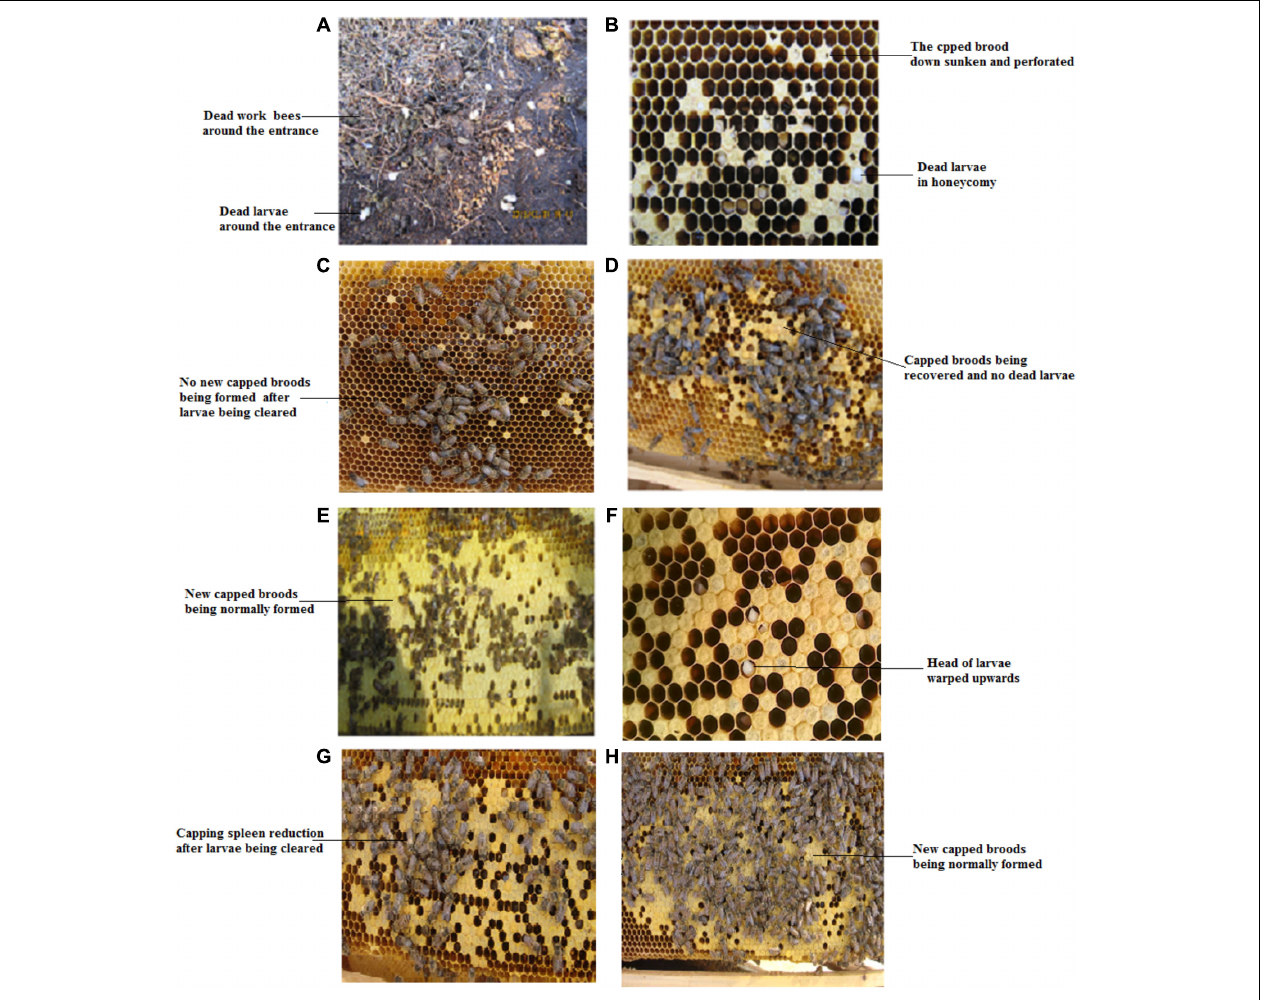
FIGURE 4 | Clinical symptoms of Apis cerana larvae infected with CSBV, and effect of treatment with anti-CSBV IgY. (A) Numerous larvae were dragged out of the colony, and dead worker bees were observed in the serious infection group. (B) Capped broods not being normally sealed, down sunken and perforated, were observed in the serious infection group. (C) No new capped broods being formed after larvae infected with CSBV being cleared in the serious infection group. (D) New capped broods begin to be formed, and no larvae were dragged out of the colony from 7 to 13 days after IgY treatment in the serious infection group. (E) The heads of larvae infected with CSBV were warped upward. (F) The capped brood was normally sealed from 18 to 21 days after IgY treatment. (G) Capping spleen reduction after larvae infected with CSBV being cleared in the moderate infection group. (H) New capped broods were normally formed 10 to 14 days after IgY treatment in the moderate infection group.